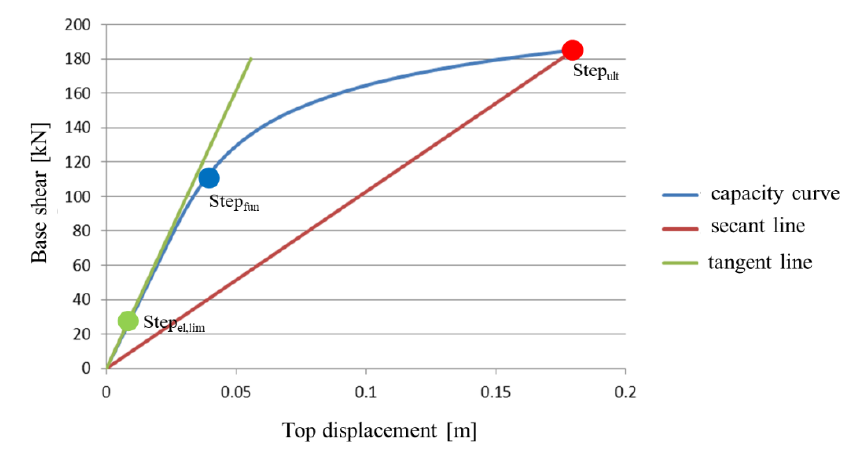
Figure 16. Fiber discretization of the chimney base section.